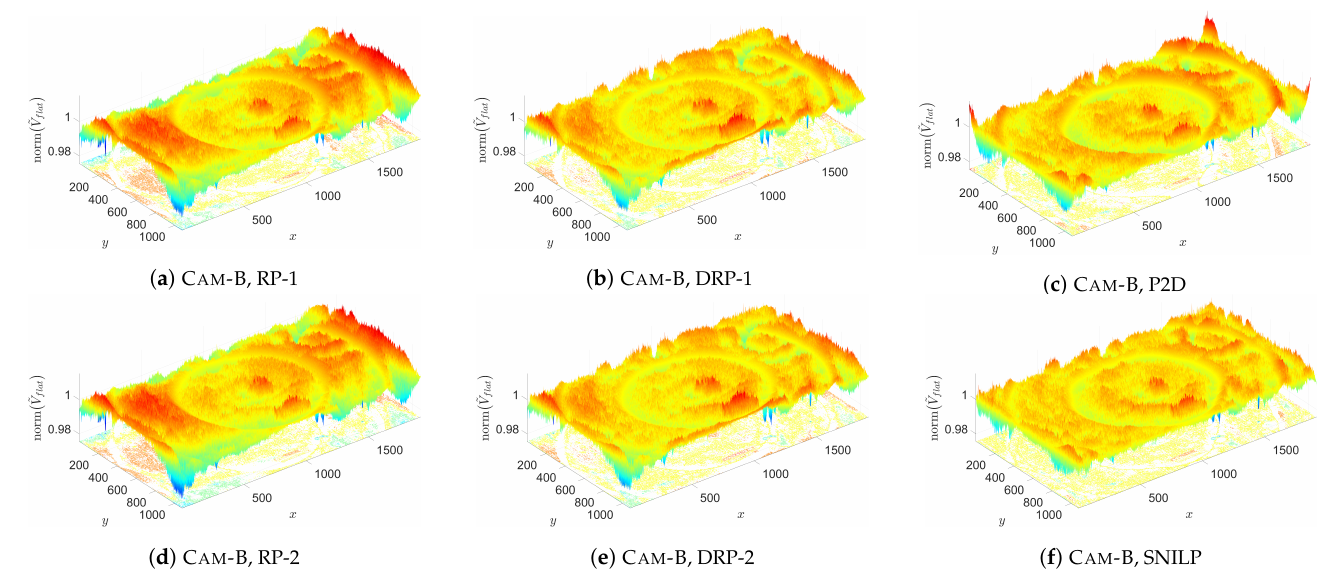
Figure A4. Comparison of vignetting corrections of flat-field image I V for C AM